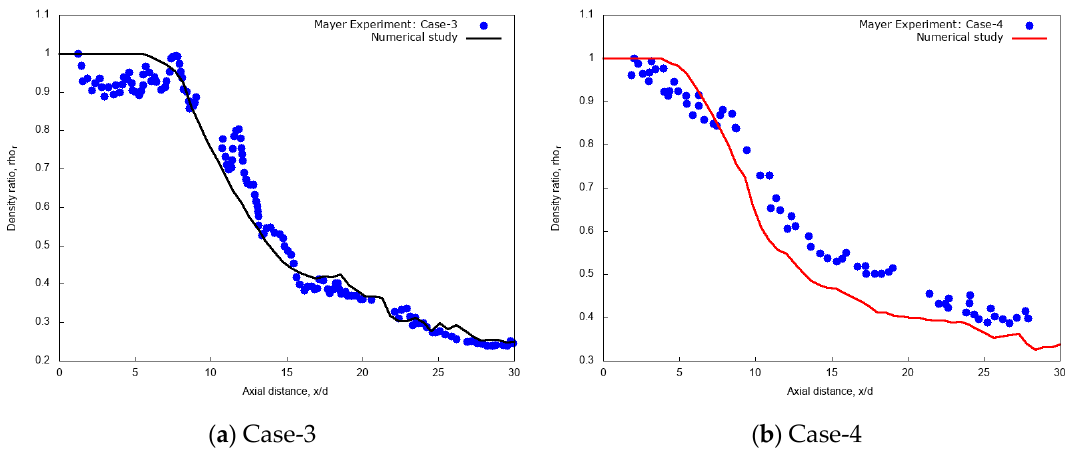
Figure 4. Centerline time-averaged non-dimensional density ratio profile along the axial distance obtained from the present numerical study of injection of cryogenic L-N 2 into supercritical chamber at p ch = 4 MPa and T ch = 298 K ( a ) Case-3: at T inj = 126.9 K, u inj = 4.9 m/s and ( b ) Case-4: at T inj = 131 K, u inj = 5.4 m/s with uniform grid resolution per jet diameter, d /64 compared with experimental test case-3 and case-4 of Mayer et al. [55].